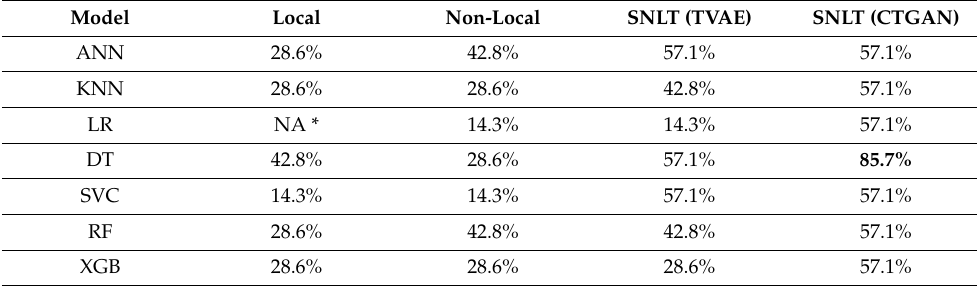
Table 4. Train KY, test GA: best accuracies from GA local training, non-local training (KY), and SNLT with CTGAN and TVAE (KY), each for three class labels (high, medium, and low yield), with synthetic dataset size of 1000 samples, except XGBoost, which is 200,000 samples. Highest accuracy is